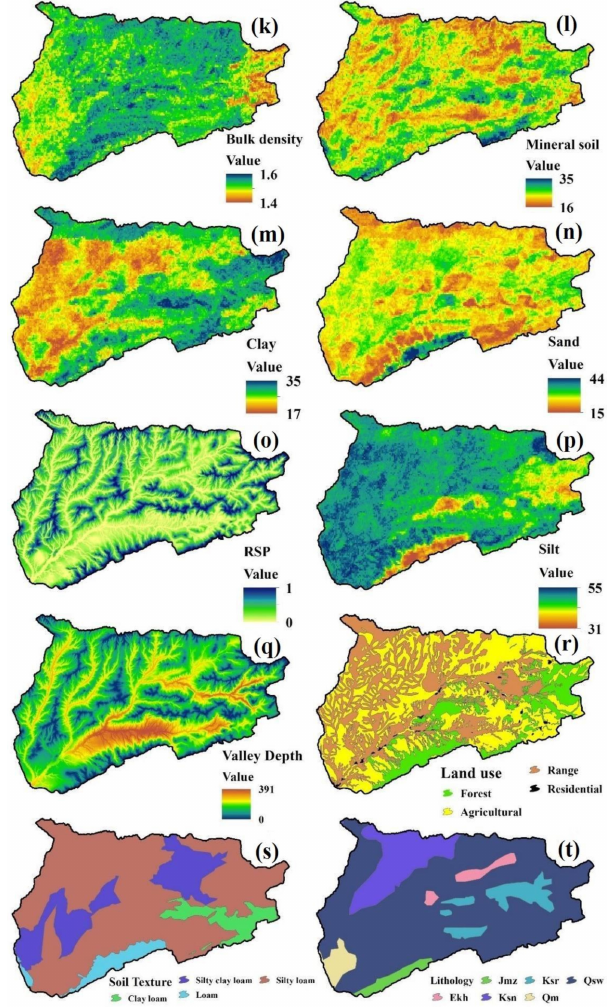
Figure 4. Gully erosion factors are showing ( a ) Topography position index (TPI), ( b ) Plan curvature, ( c ) Elevation, ( d ) Aspect, ( e ) Slope, ( f ) Height above nearest drainage (HAND), ( g ) Drainage density, ( h ) Distance from stream, ( i ) Terrain ruggedness index (TRI), ( j ) Distance from road, ( k ) Bulk density, ( l ) Mineral Soil, ( m ) Clay content, ( n ) Sand content, ( o ) Relative slope position (RSP), ( p ) Silt content, ( q ) Valley depth, ( r ) Land use, ( s ) Soil Texture, ( t ) Lithology. Table 3. Detailed information about the